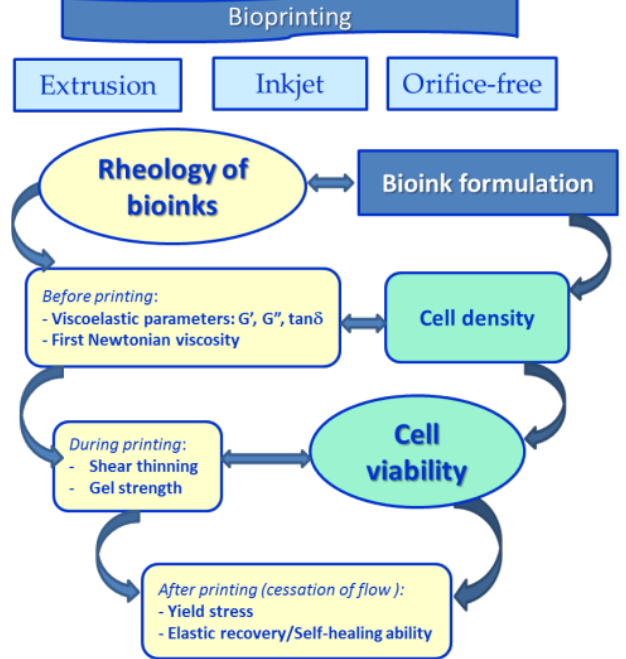
Scheme 1. Overview of key parameters in